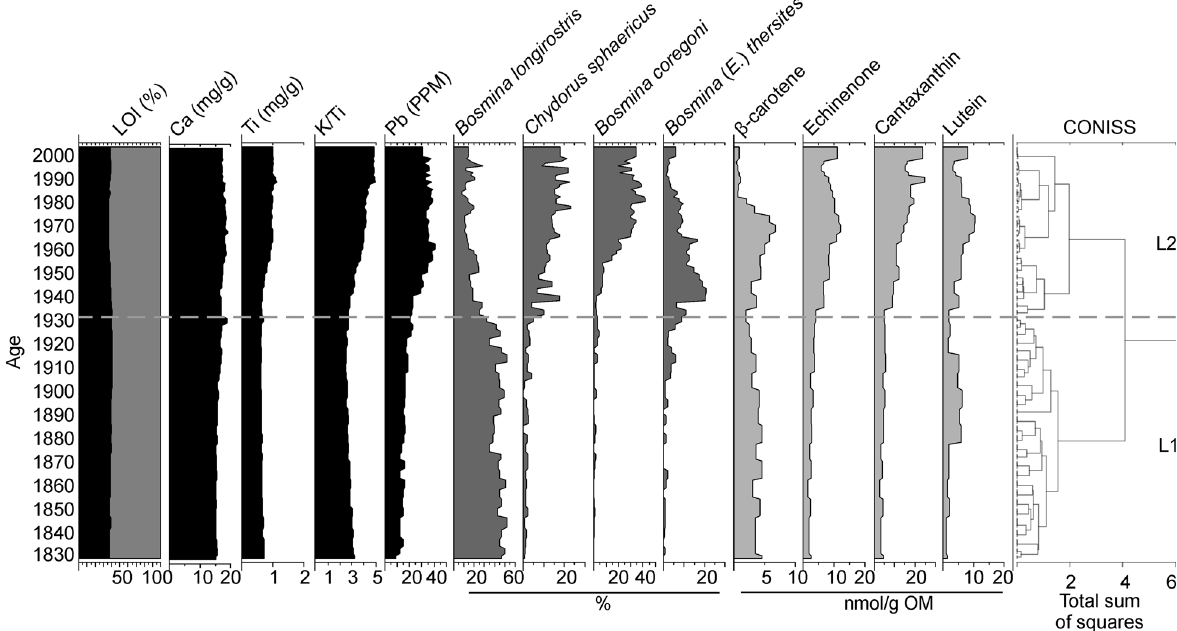
Fig. 3. Selected variables from the sediment of Lake Lohja in age scale and results of CONISS analysis of all data (77 variables). Loss on ignition (LOI 550) data are marked as follows: black – organic matter; grey – mineral